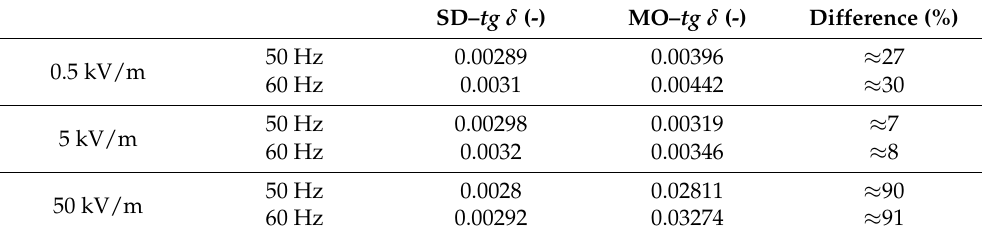
Figure 15. The dielectric dissipation factor tg δ of electrical insulating oils in the frequency band of decimal graduated intensity E of the time-varying electric field. Table 4. Dielectric dissipation factor tg δ values at mains